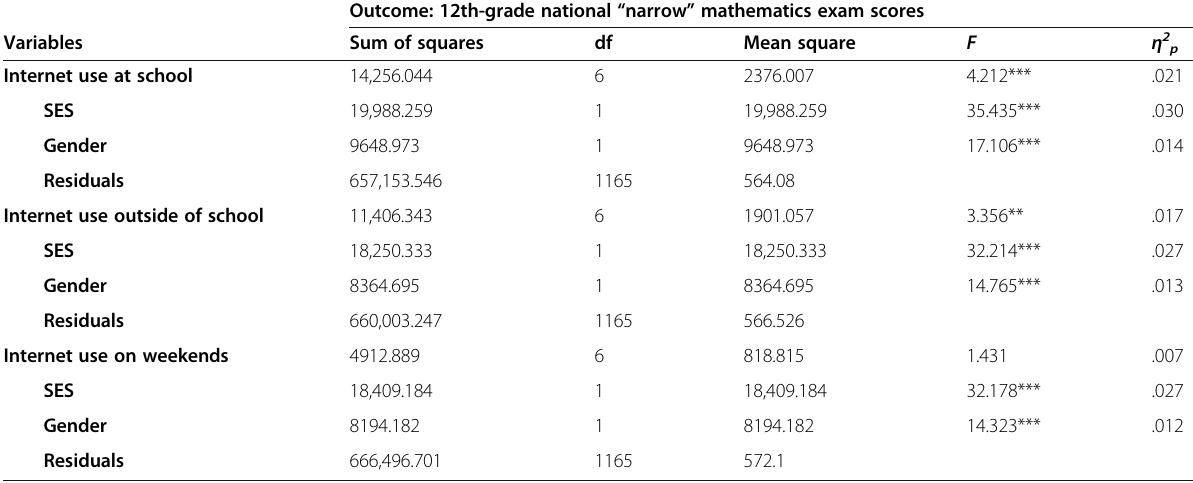
Table 5 Results of ANCOVA analyses for 12th-grade “ narrow ” mathematics national exam scores and Internet use variables, controlled for SES and gender Outcome: 12th-grade national “ narrow ” mathematics exam scores Variables